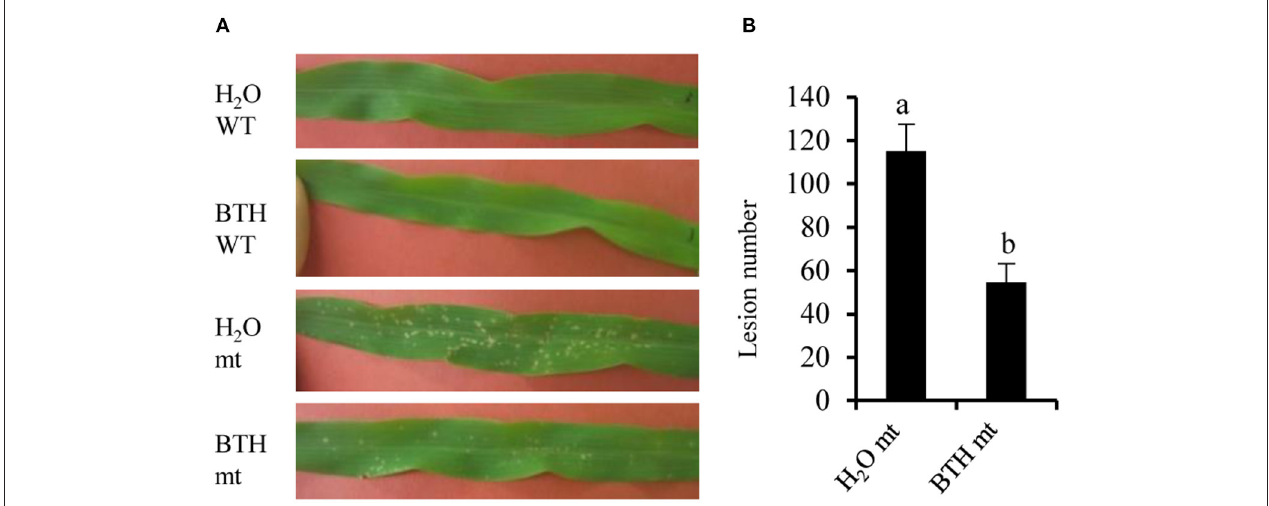
FIGURE 6 | Benzothiadiazole (BTH) treatment reduced Rp1-D21-mediated HR. (A) Plants in Mo17 × H95 background were grown at 30 ◦ C for 8 days, then the plants were treated by H 2 O or 1.2mM BTH. After treatment, the temperature was dropped to 22 ◦ C to induce hypersensitive response (HR), and the pictures of the third leaves were taken at 4 days after temperature shift. (B) The lesion number in mutant (mt was calculated after H 2 O and BTH treatment. Significant differences ( p < 0.05) between samples are indicated by different letters (a,b). Wild type (WT) and Rp1-D21 mutant